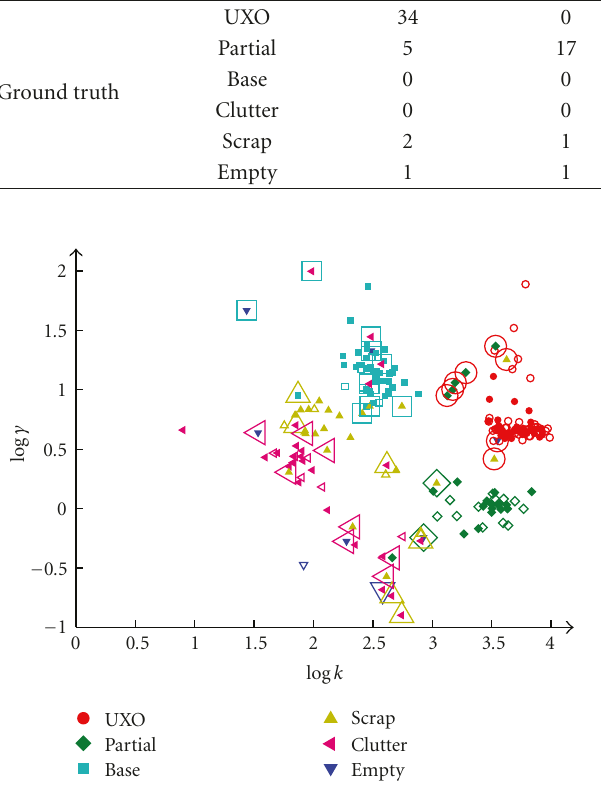
Figure 8: Result of the SVM classification for the Camp Sibert anomalies using the logarithms of the Pasion-Oldenburg parame- ters β and γ . The SVM capacity C = 10 5 . The small markers denote the ground truth for both training (hollow) and testing (solid) cells. The larger markers highlight the wrong predictions made by the